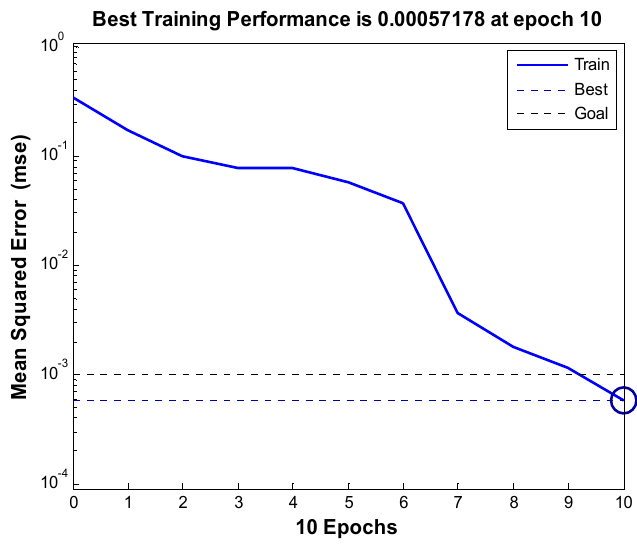
Figure 16. Error convergence curve.